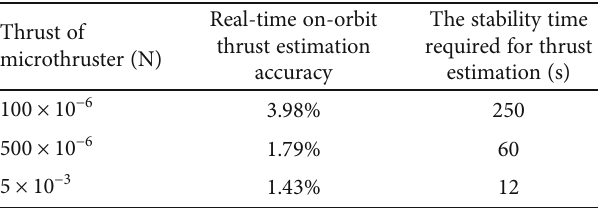
Table 2: Three kinds of thrust real-time on-orbit estimation accuracy and required stabilization time. Thrust of microthruster